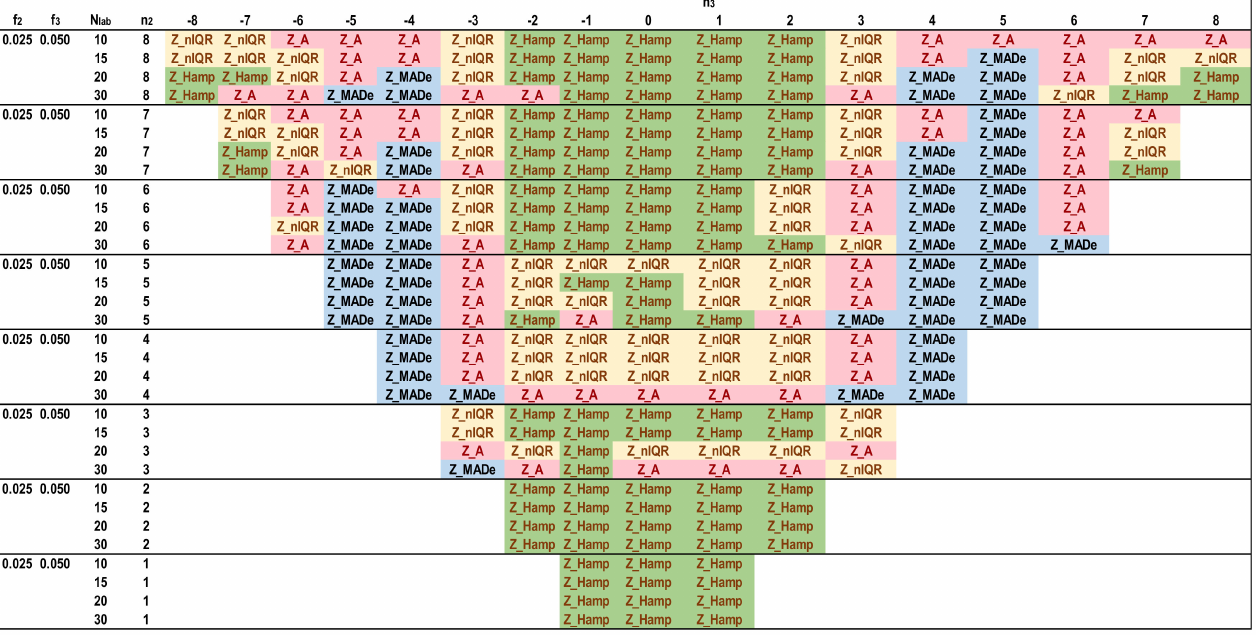
Figure 13. Optimal robust estimators of Zu% for trimodal distributions, f 2 = 0.025 and f 3 =